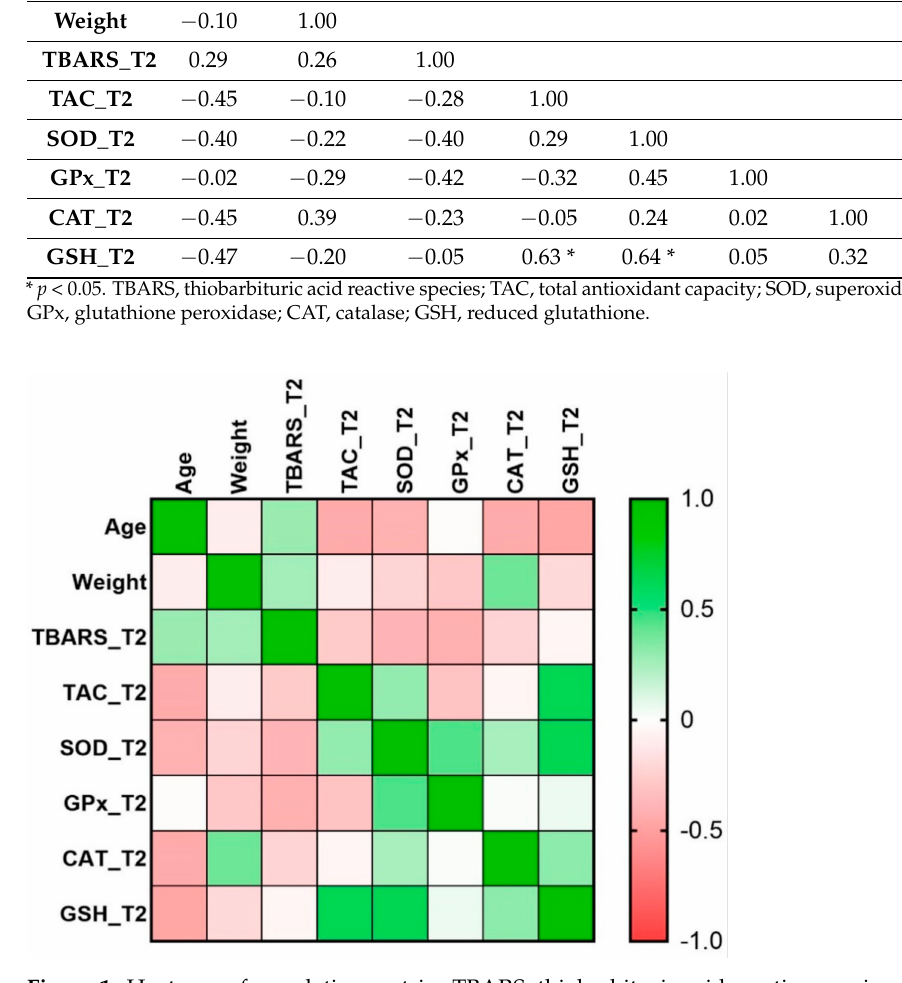
Figure 1. Heatmap of correlation matrix. TBARS, thiobarbituric acid reactive species; TAC, total antioxidant capacity; SOD, superoxide dismutase; GPx, glutathione peroxidase; CAT, catalase; GSH, reduced glutathione. T2, after 60 days of antituberculosis